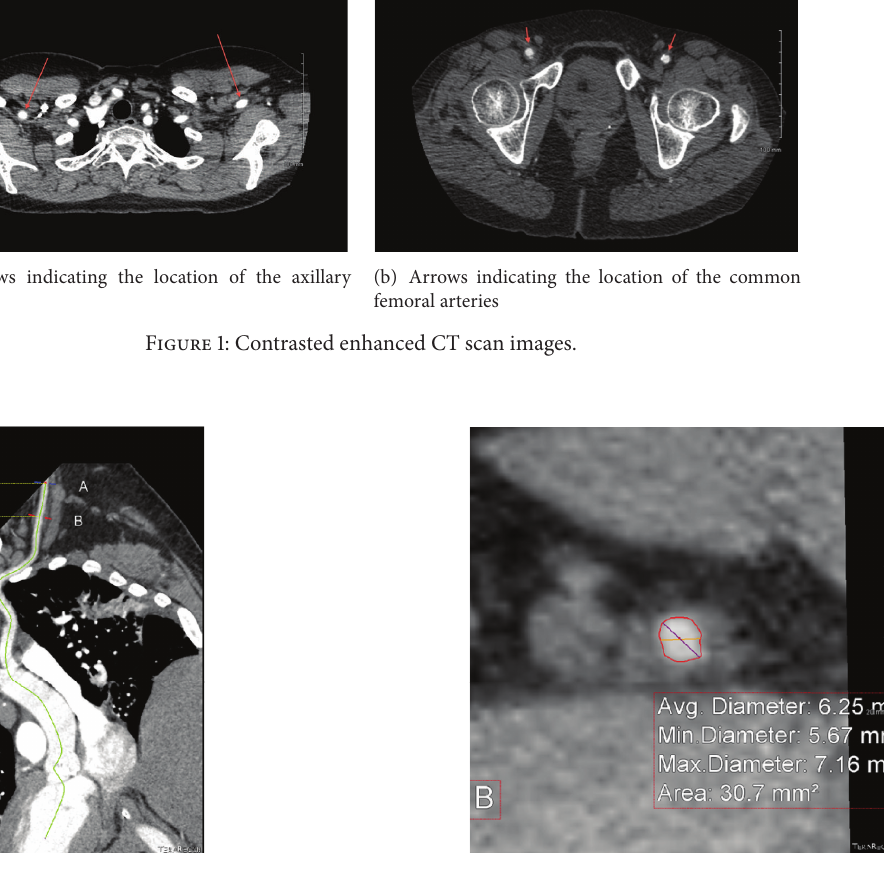
Figure 3: Cross-sectional image of the axillary artery with measure- ment of diameter at point